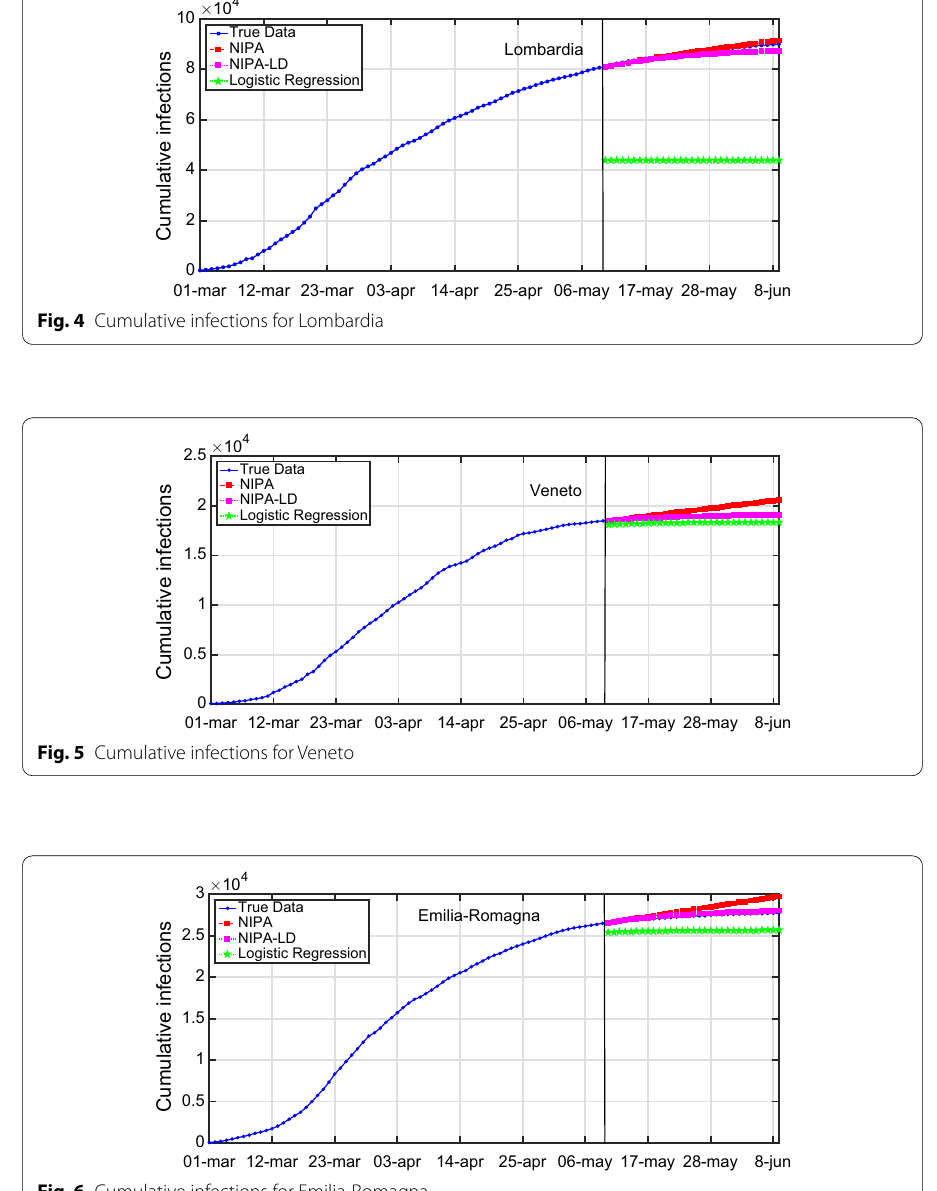
Fig. 6 Cumulative infections for